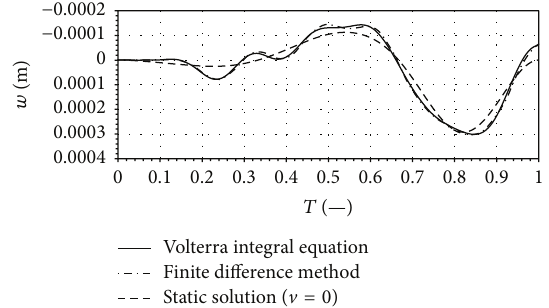
Figure 19: Dynamic deflection of point “c” due to a moving force.